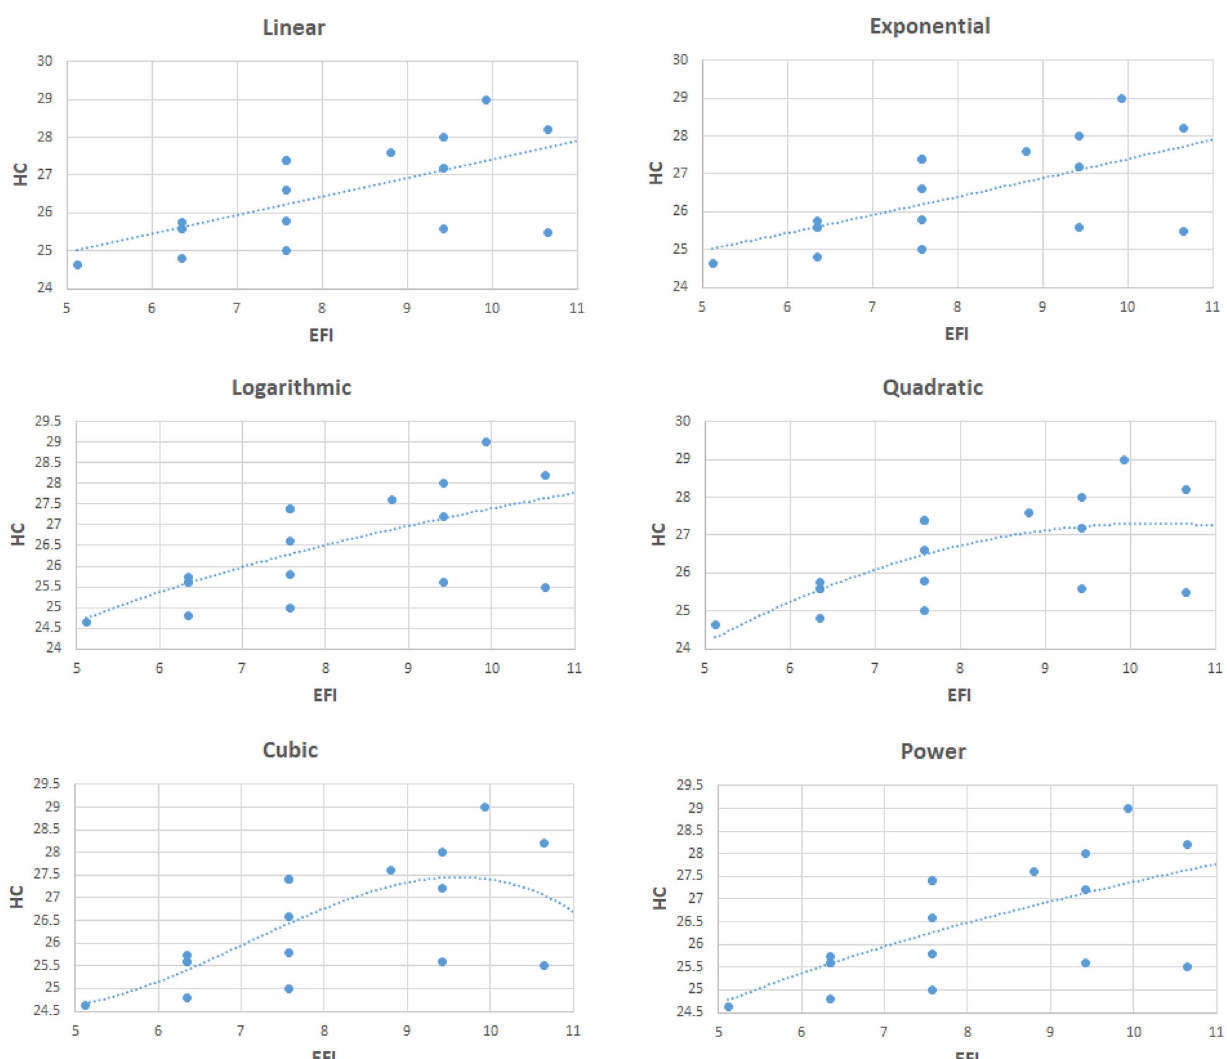
Fig. 2 The correlation of edge F-index with heat capacity for octane isomers